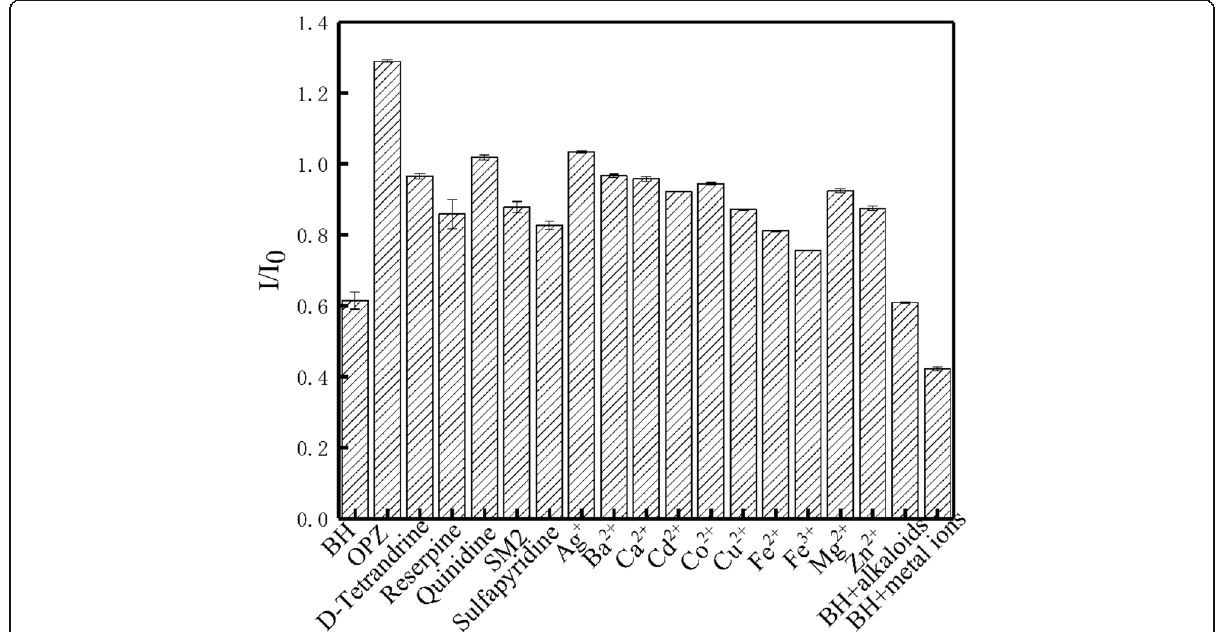
Fig. 4 Selectivity of the CPC-CQDs sensors in the presence of 50 μ M various alkaloids and metal